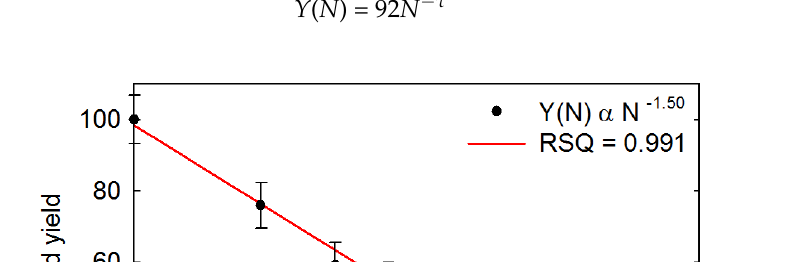
Figure 6. Cluster size distribution of cytochrome c from trimer to 30-mer. The cluster size (x-axis) and the normalized relative intensity (y-axis) are plotted on a base-10 logarithmic scale.